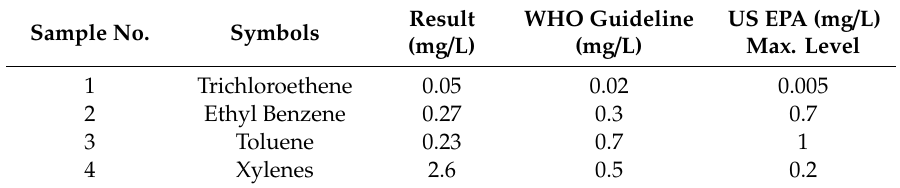
Table 9. Polluted soil samples with LNAPL according to World Health Organization (WHO) and Environmental Protection Agency (EPA) standards. Sample No.